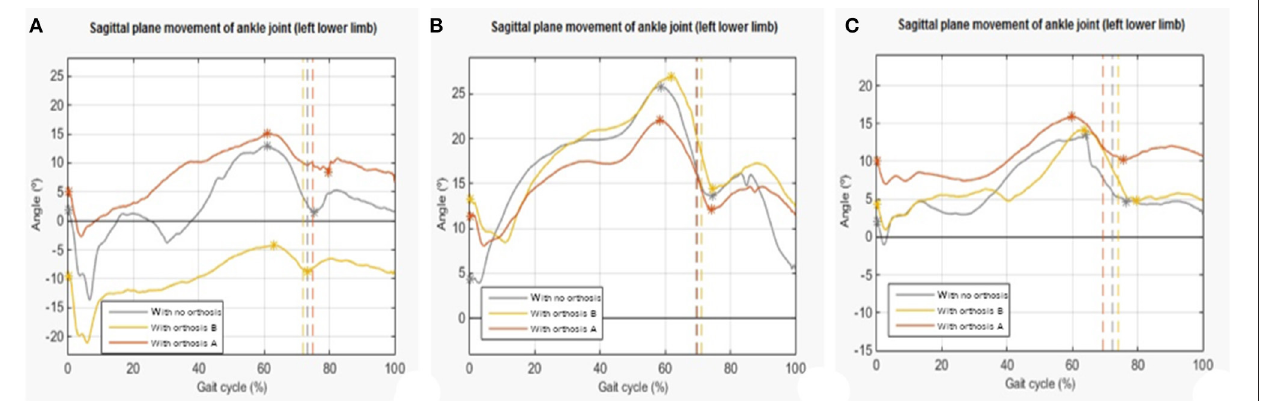
FIGURE 2 | Examples of plots representing the sagittal plane movement of the ankle joint of the pathological lower limb in the three conditions in the analysis. (A) Trial 1 of subject 1. (B) Trial 1 of subject 2. (C) Trial 1 of subject 3. The vertical line presents the contact phase, and the * is the higher value.